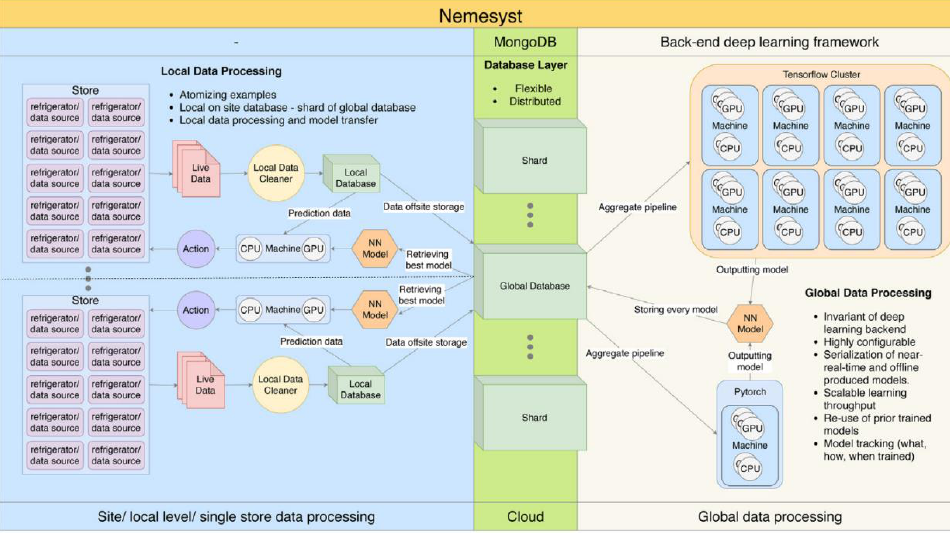
Figure 6. The Nemesyst system for AI-enabled power supply control of retailing